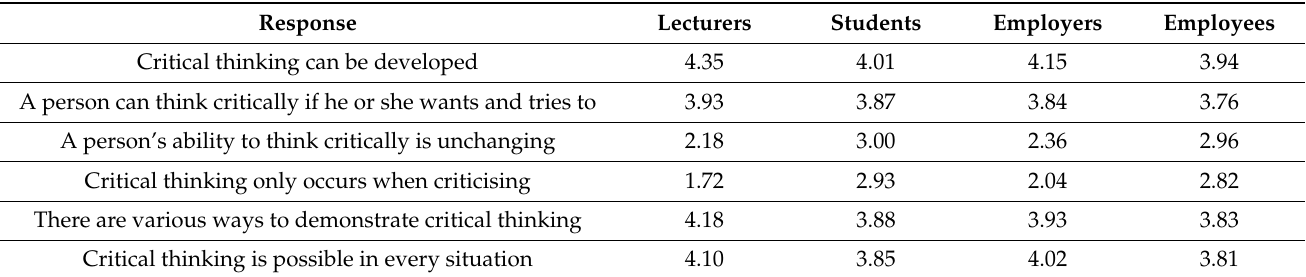
Table 3. Comparison of views regarding the manifestation and development of critical thinking (arithmetic mean (M), where 1 is ‘strongly disagree’ and 7 is ‘strongly